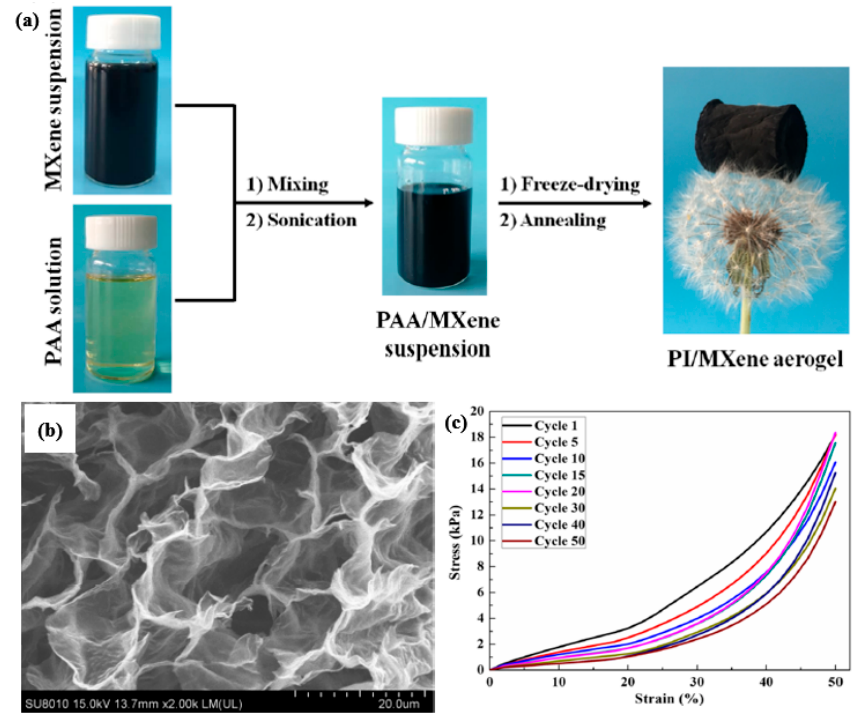
Figure 10. ( a ) Preparation route of PI / Ti 3 C 2 T x aerogels ( b ) Internal structure of PI / Ti 3 C 2 T x -3 aerogels ( c ) Stress − strain curves for 50 repeated compression cycles on the PI / MXene-3 aerogel at 50% strain. Adapted and reproduced with permission from [113]. Copyright ACS,